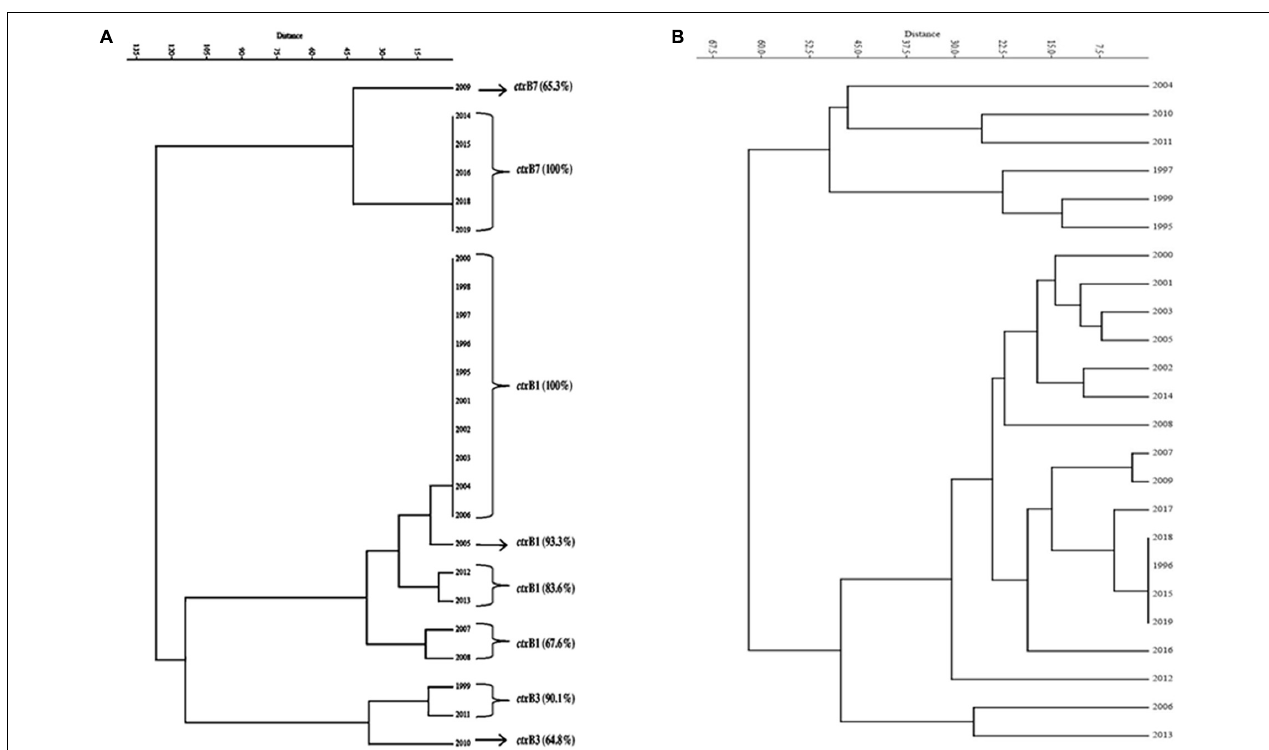
FIGURE 2 | Dendrogram drawn using PAST 4.03 software. (A) Cluster analysis of the estimate of genetic similarity between ctx B genotypes present in V. cholerae O1 strains in different years. (B) Cluster analysis of the estimate of percentage similarity of virulence-associated genes (VAGs) present in V. cholerae O1 strains in different